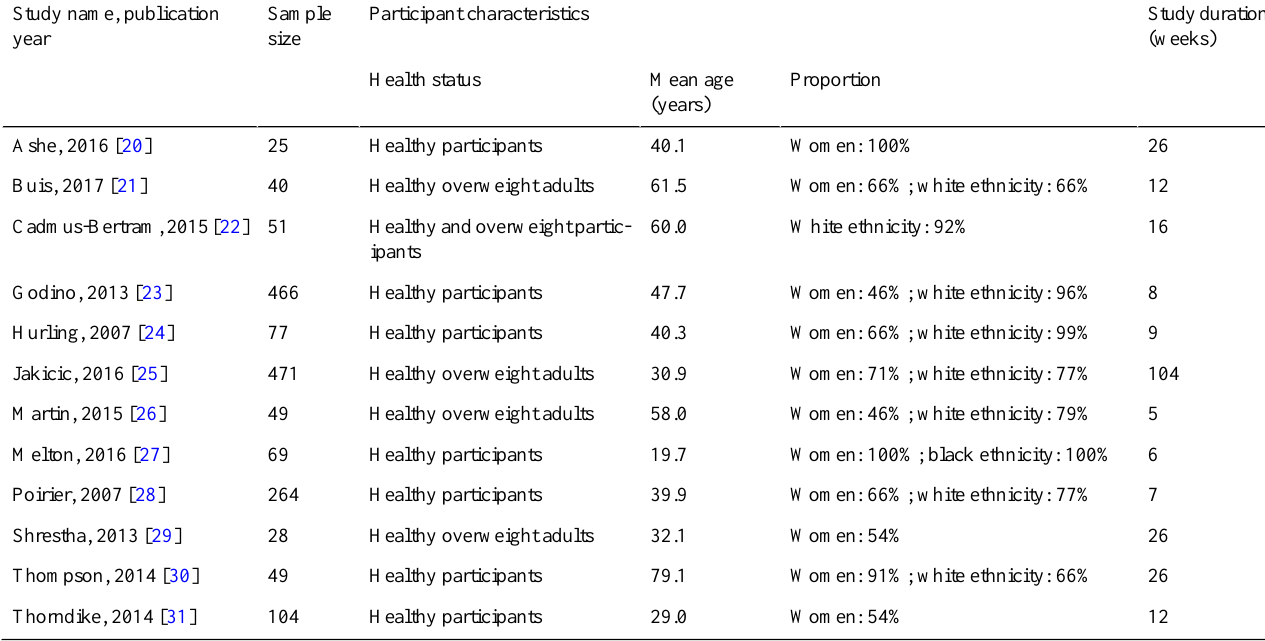
Table 1. Characteristics of participants in the included